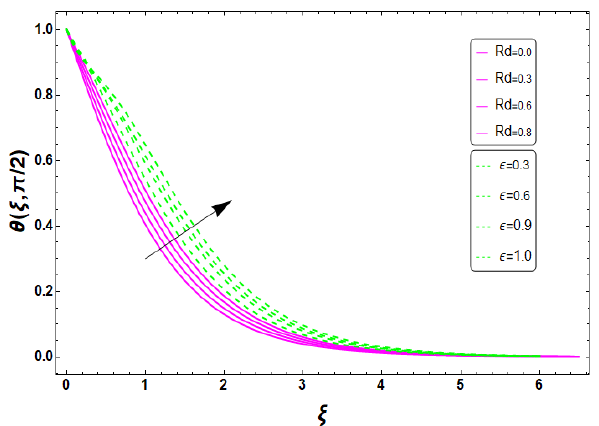
ε . Figure 11. Profile of θ for various values of Rd and ε